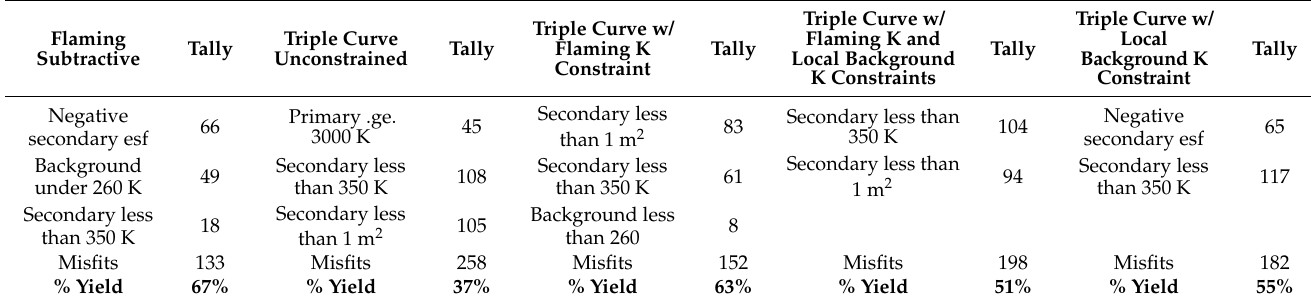
Table 3. Scoring of the five